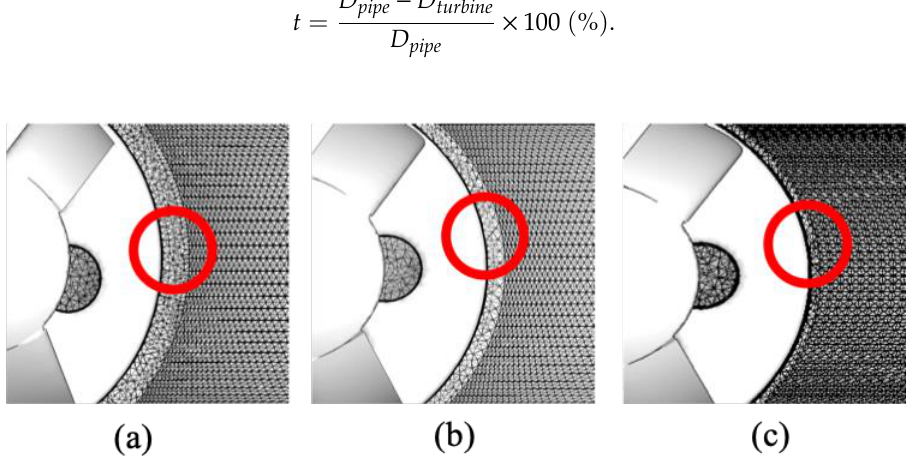
Figure 7. Detailed view of the tip clearance and domain interface: ( a ) 19.3% clearance, ( b ) 15.0% clearance and ( c ) 12.0% clearance.